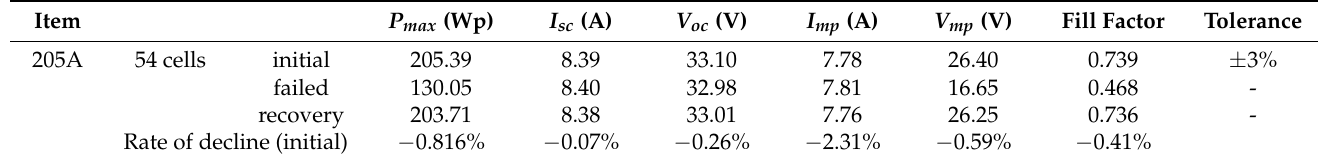
Table 4. Electrical data deviations of the initial, failed, and recovered module (205A).